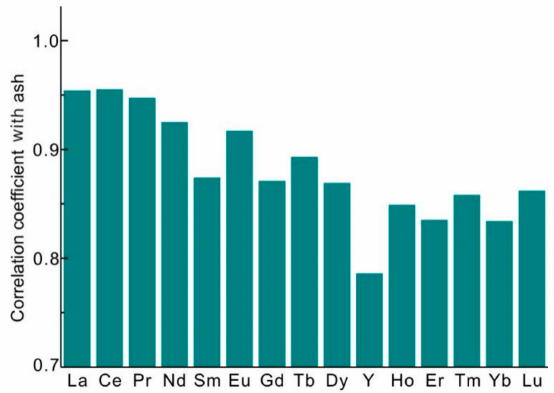
Figure 7. Correlation coefficients between individual REE and ash